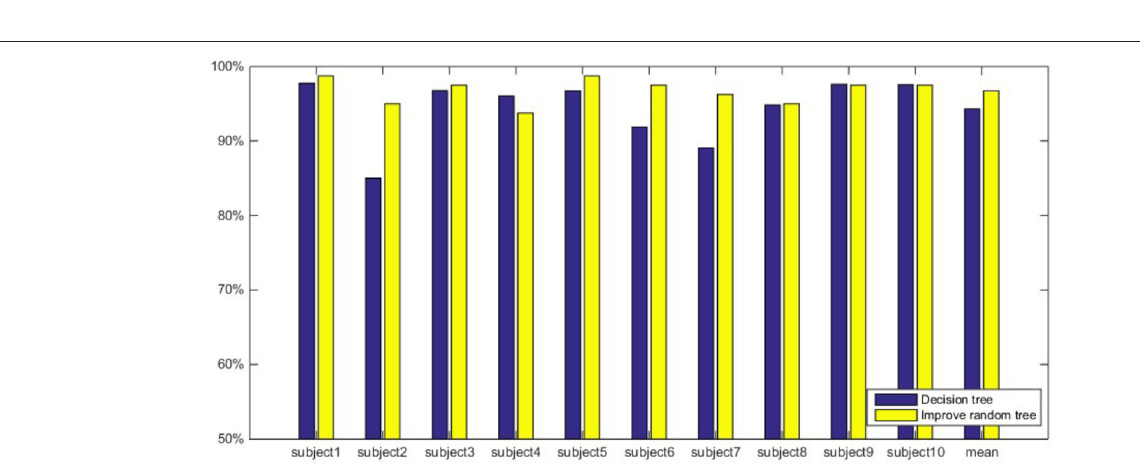
Frontiers in Psychology |